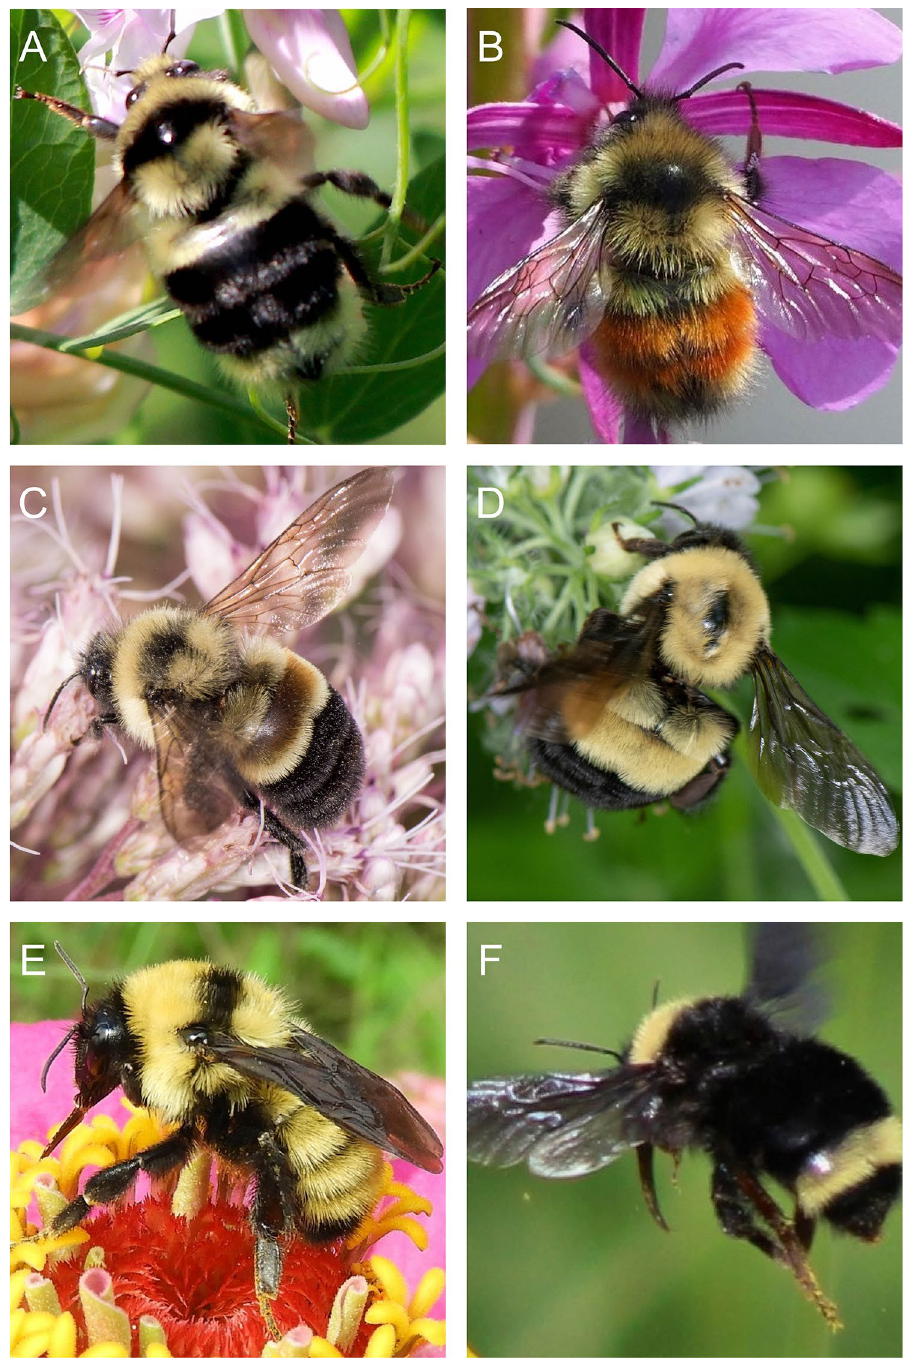
Figure 1. Example test images showing coarse scale intraspecific variability in appearance. Bombus melanopygus are ( A ) without orange coloration in the southern part of their range but ( B ) with orange on the northern end. ( C ) A B . affinis worker displaying its characteristic rusty-colored patch on T2 of its abdomen, however ( D ) the patch is usually absent or reduced on queens. B . fervidus has ( E ) extensive yellow coloration in the eastern part of its range, but ( F ) is more extensively black in the western end. Photo credits: ( A ) Andrea Kreuzhage, ( B ) Scott Ramos, ( C , D ) Heather Holm, ( E ) Sue Gregoire, ( F ) Asa B.